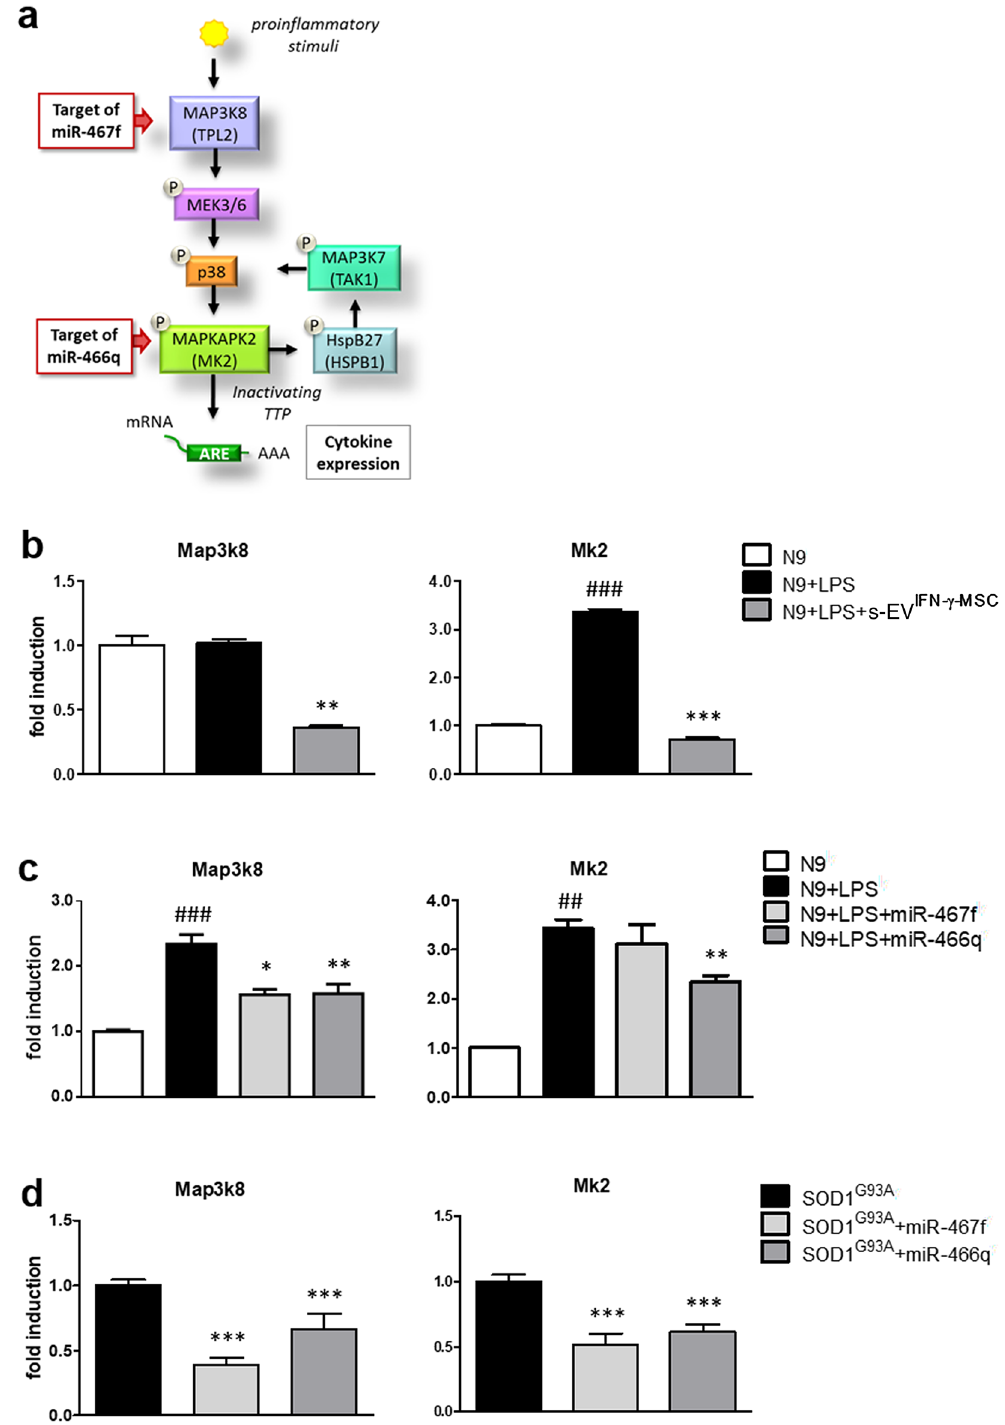
Figure 4. Transfection of microglia with miR-467f, miR-466q, or exposure to s-EV IFN-γ-MSC , inhibits Map3k8 and Mk2 expression. ( a ) Scheme of p38 MAPK signaling pathway showing that Map3k8 and Mk2 are specific targets of miR-467f and miR-466q, respectively. ( b ) Exposure of LPS-activated N9 cells to s-EV IFN-γ-MSC induced a significantly downregulation of Map3k8 and Mk2 mRNA expression. ### P < 0.001, untreated (N9) vs LPS-activated N9 cells (N9 + LPS); ** P < 0.01, *** P < 0.001, N9 + LPS vs N9 + LPS exposed to s-EV IFN-γ-MSC (N9 + LPS + s-EV IFN-γ-MSC ). ( c ) Downregulation of Map3k8 and Mk2 mRNA expression in LPS-activated N9 cells transfected with miR-467f and miR-466q confirm that they are target genes for these miRNAs. ### P < 0.001, untreated (N9) vs LPS-activated N9 cells (N9 + LPS); * P < 0.05, ** P < 0.01, N9 + LPS vs N9 + LPS transfected with specific miRNA (N9 + LPS + miRNA). ( d ) Primary microglia obtained from SOD1 G93A mice transfected with miR-467f and miR-466q showed a significant downregulation of the expression of genes involved in the p38 MAPK signaling pathway. * P < 0.05, *** P < 0.001, SOD1 G93A vs SOD1 G93A + miR467f or 466q. Data are presented as mean ± SEM of 3 independent experiments conducted in